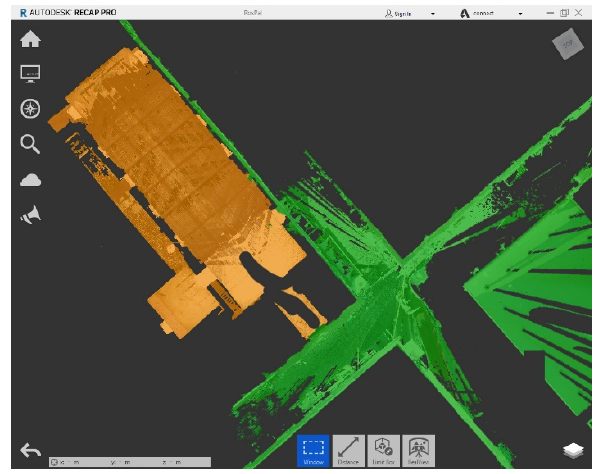
3D.Figure 2: Managing of the laser scanner point cloud in Autodesk Recap Pro software: segmentation and clearing